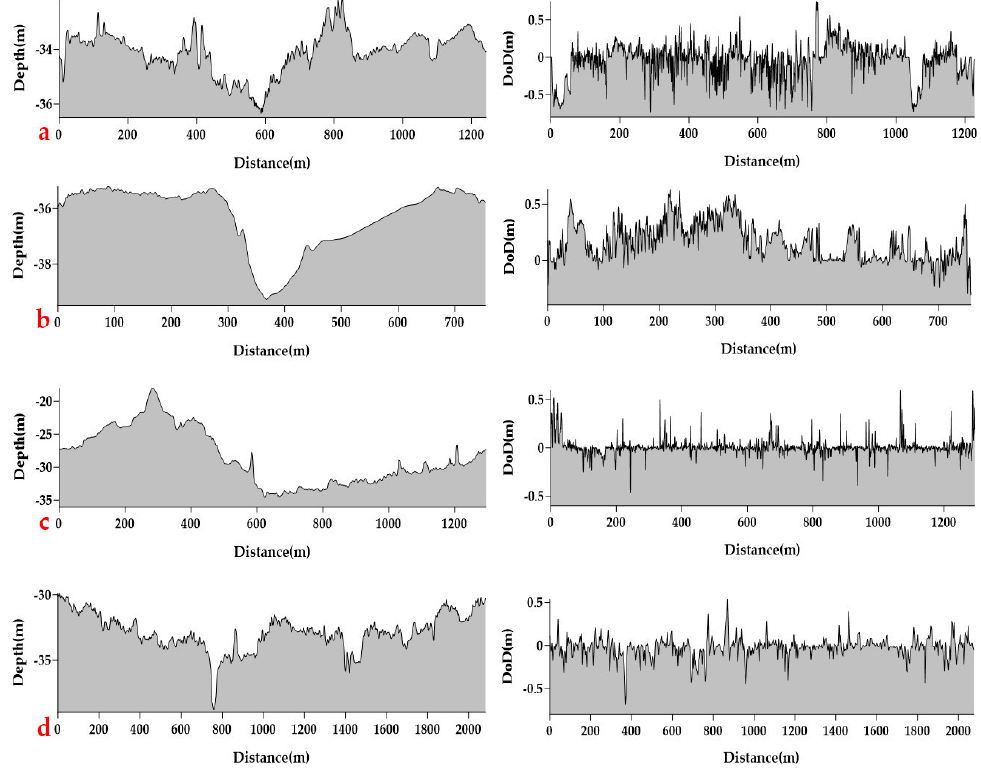
Figure 9. Comparison of the depth and DoD values for four representative profiles of the four regions.